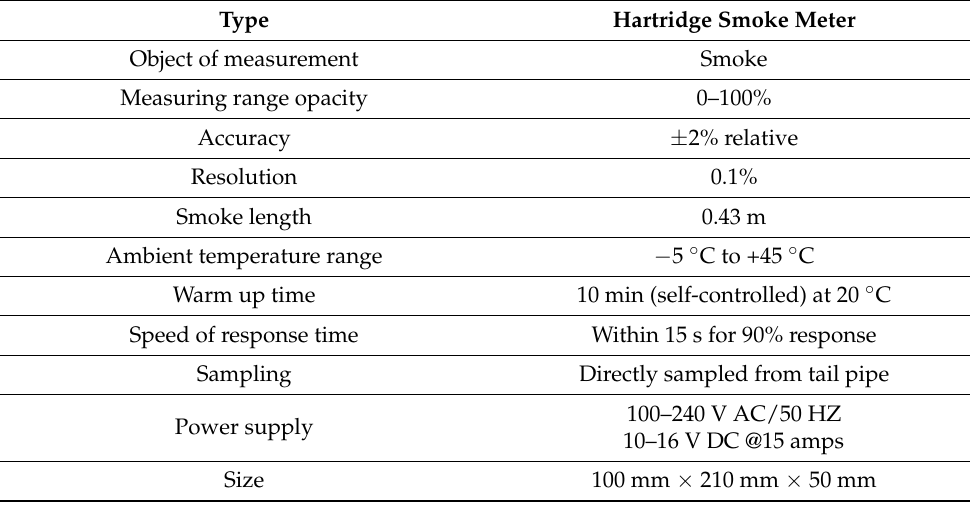
Table 5. Specifications of smoke